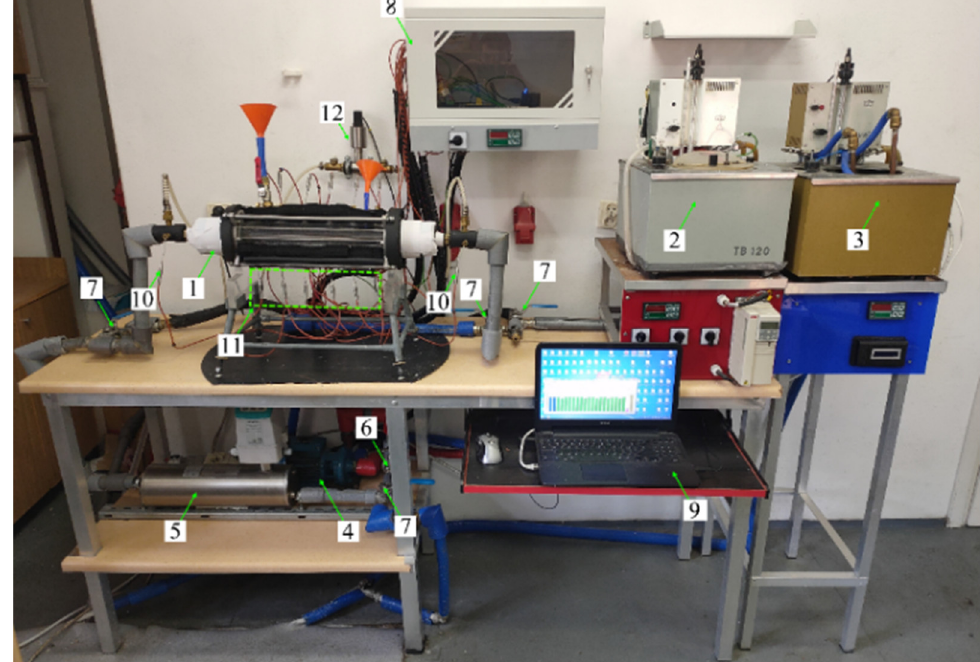
Figure 1. View of the experimental stand: 1—LHSS, 2—hot water thermostat, 3—cold water thermostat, 4—pump, 5—ultrasonic flow meter, 6—needle valve, 7—three-way valve, 8– multiplexer, 9—PC, 10–11– resistance thermometer, 12—pressure difference transducer.